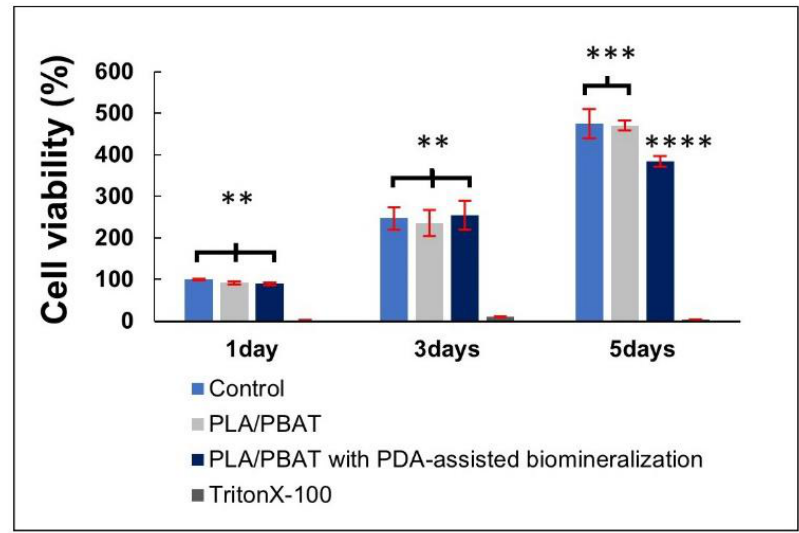
Figure 11. The indirect MTT assay results on the cell viability of MG-63 human osteoblast-like cells. The different numbers of the asterisks represent the statistical significance ( p ≤ 0.05).